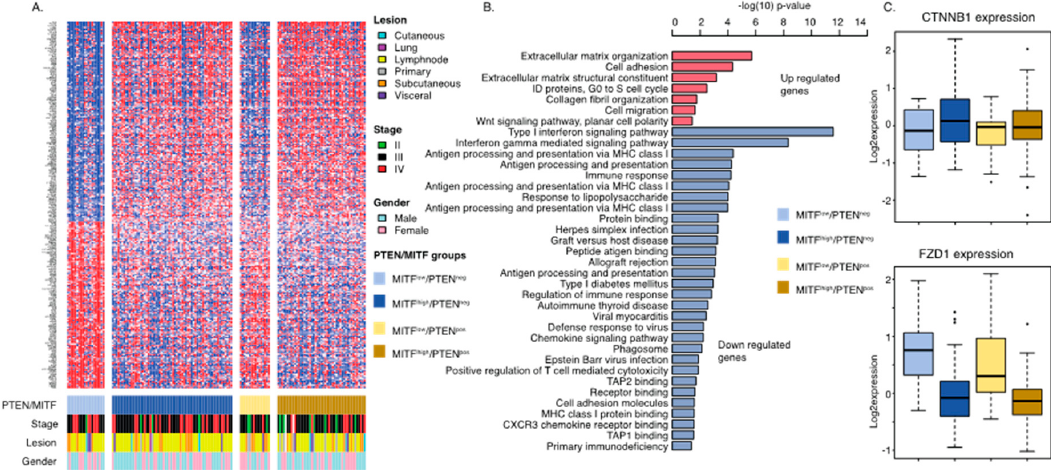
Figure 4. Transcriptional analysis of MITF low /PTEN neg melanoma tumors. ( A ) SAM analysis identified genes (n = 276) characteristic of MITF low /PTEN neg melanoma tumors. ( B ) Bar plot showing results from the gene ontology analysis using the 276 genes di ff erentiating MITF low / PTEN neg melanoma tumors from other melanomas. Notably, there are two cell adhesion molecule gene ontology terms. Genes downregulated (blue) include immune adhesion molecules, while upregulated genes include classical adhesion molecules such as N-cadherin. ( C ) Boxplots of the CTNNB1 (beta-catenin) and FZD1 gene expression value across the MITF / PTEN groups. CTNNB1 shows no significant di ff erence ( p = 0.24), while FZD1 expression shows a significant di ff erence ( p < 0.0001).